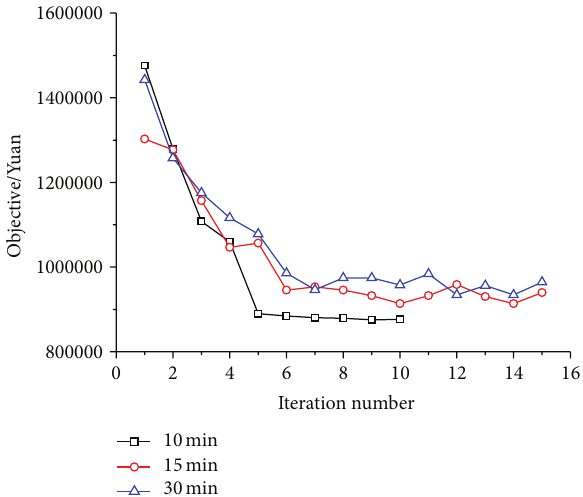
Figure 7: The change relation of computing time with the iteration